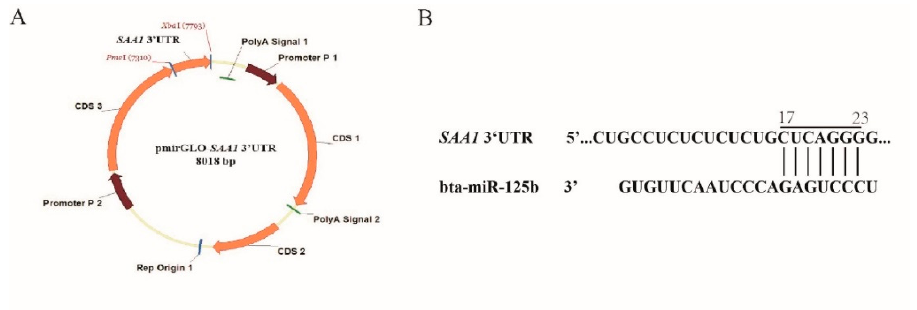
Figure 1. ( A ) The pmirGLO vectors with the predicted 3 ′ UTR target sequences of the expressed gene, pmirGLO-SAA1-3 ′ UTR; ( B ) Locations and sequences of the miRNA target sites in the 3 ′ UTR of the expressed gene. The sequences of the miRNAs are indicated, along with mutations introduced in the target sites (underlined nucleotides) for generating the mutated reporter constructs.